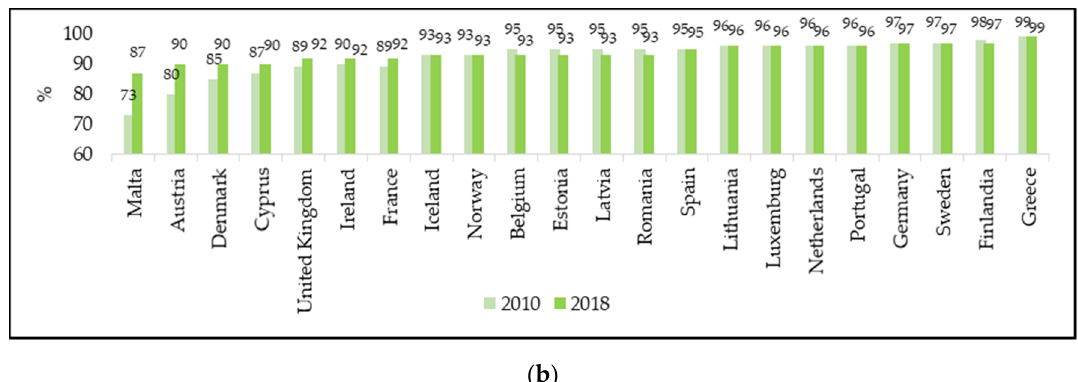
Figure 2. Vaccination coverage for the first dose of measles-containing vaccine in 2010 and 2018: ( a ) Countries with mandatory vaccination. Italy is listed among the countries with mandatory vaccination due to its change in vaccination policies in 2017; ( b ) countries with recommended vaccination (WHO/UNICEF reports). France is included in the recommended vaccination countries because vaccination, made mandatory for children born from 2018, has not yet been performed in the 2018 cohort.